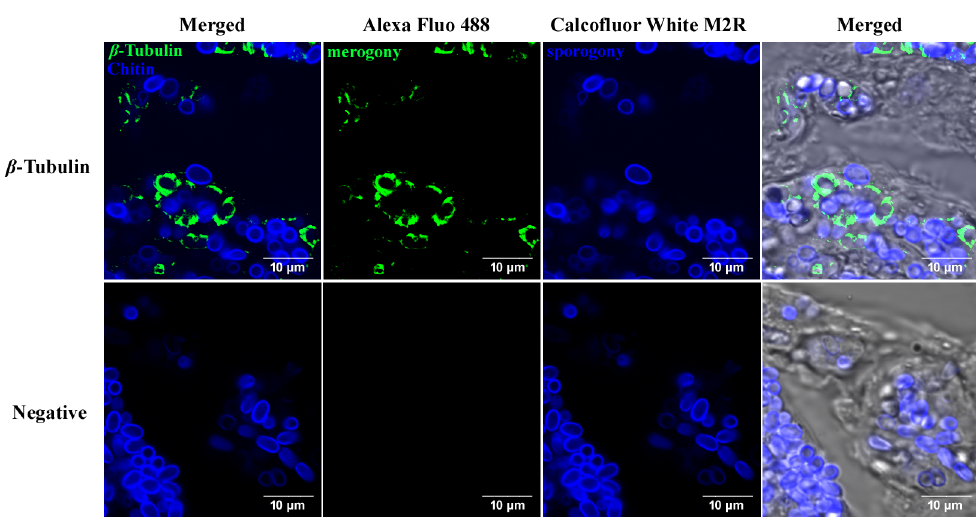
Fig 4. Labeling the two different intracellular phase of microsporidian N . bombycis by immunofluorescencehistochemistry in intestinal tissue slices. β - Tubulinantibody coupledwith Alexa Fluo 488 (green)labeledsecondary antibodywere used to label the proliferativephaseof microsporidia. Calcofluor White M2R (blue) were used to stain the chitin layer of sporogonyphase. (Bars = 10 μ m)